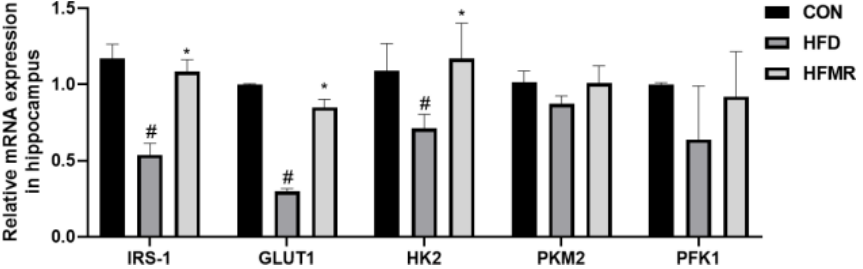
Figure 2. Effects of MR on insulin signaling in the hippocampus of HFD-induced obesity mice. All data are shown as the mean ± SEM ( n = 8). # p < 0.05, (HFD vs. CON); * p < 0.05 (HFMR vs. HFD).